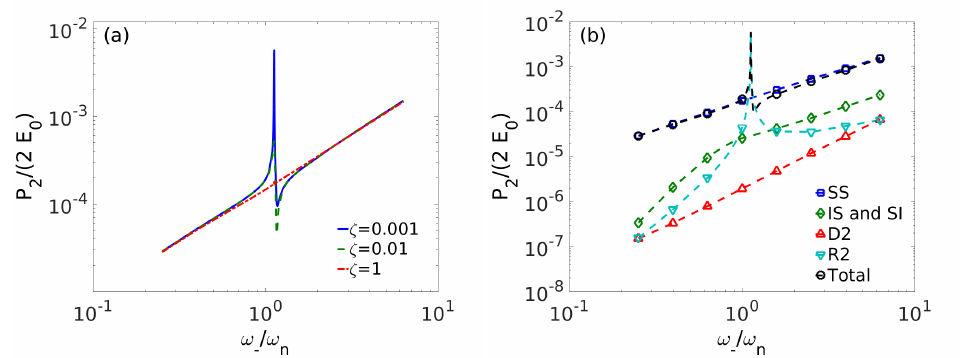
Figure 8. A resonating rigid movable sphere with collinear incident waves propagating in ˆ i z direction. P 2 − is calculated in r R = − r R ˆ i z . In ( a ), total difference frequency component of p 2 is plotted as a function of difference frequency near resonance for damping ratio ζ = 0.001,0.01,1. In ( b ), p 2 , p SS , p IS + p SI , p D2 and p R2 are shown near resonance for ζ = 0.001. When the object’s resonance is excited at the difference frequency, p R2 is amplified and it becomes dominant for small enough